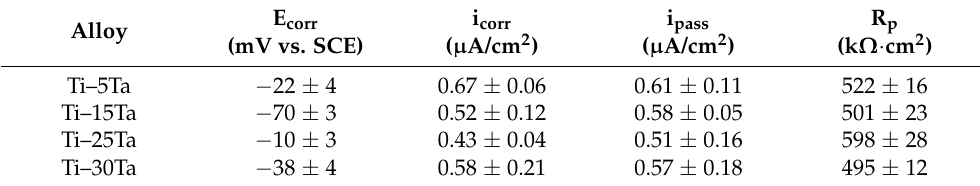
Figure 5. Polarization curves for Ti–xTa alloys. Table 4. Corrosion parameters from polarization curves (mean ± SD).